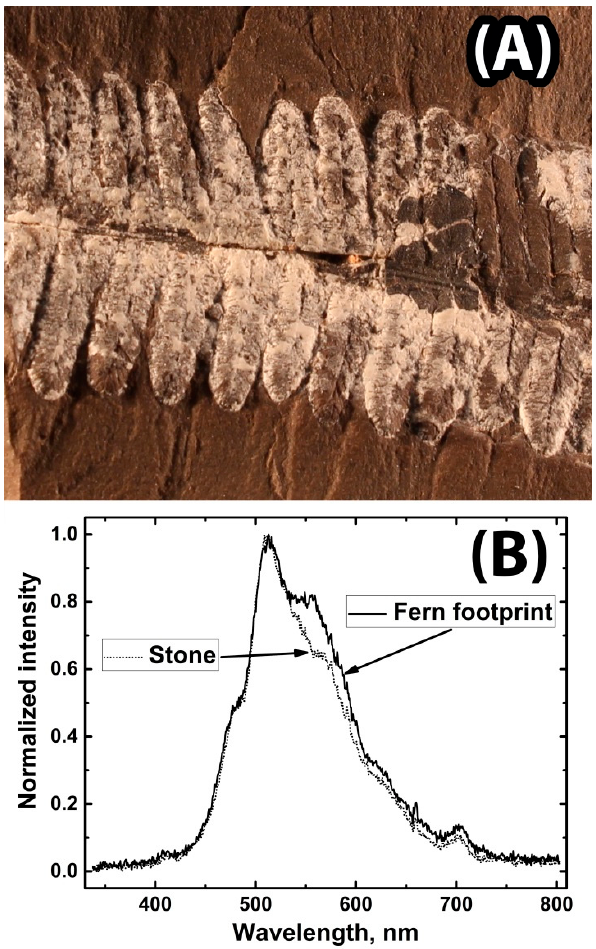
Figure 3. Laser induced fluorescence sensing of ancient fern print at a rock plate: ( A ) photograph and ( B ) fluorescence spectra of the stone inside and outside the print.